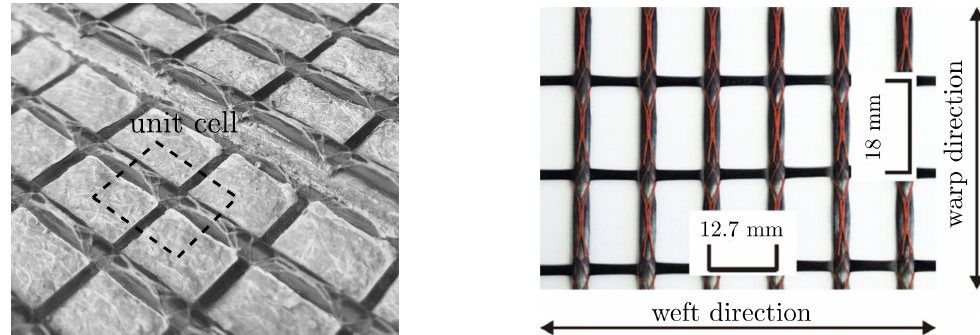
Figure 2. Mesostructural unit cell ( left ) and textile reinforcement with carbon filaments TUDALIT-BZT2- V.FRAAS adopted from [36] ( right ).